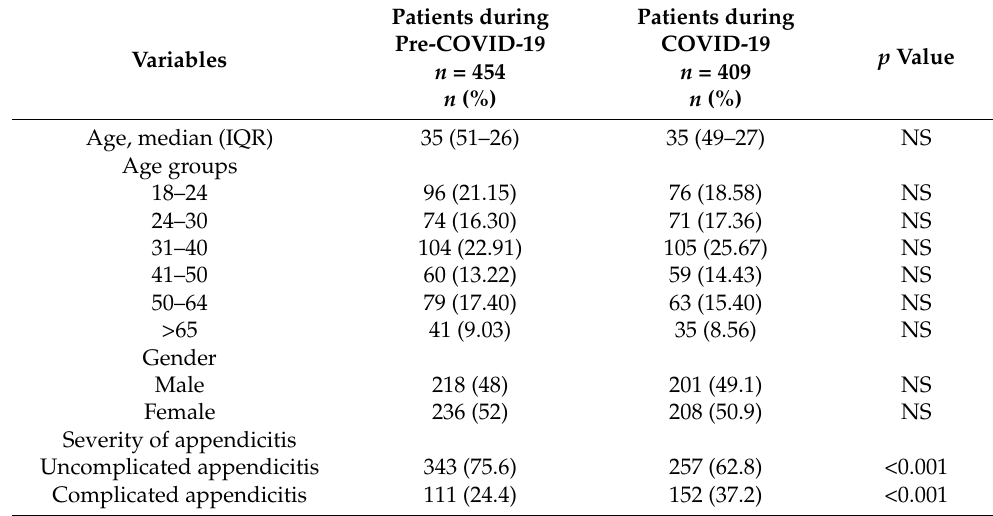
Table 1. Demographics of study population suffering acute appendicitis.